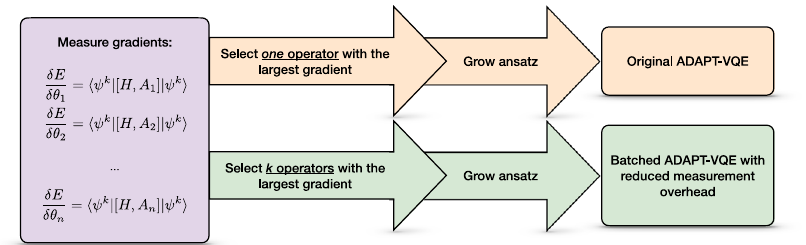
Fig. 1 Scheme of the ansatz growing procedure in original and batched ADAPT-VQE. Original ADAPT-VQE adds a single operator with the largest gradient value at each iteration. In our implementation of batched ADAPT-VQE, we add multiple operators with the largest gradients at each step of the ansatz growing procedure; k is the number of gradients that differ from the largest one by less than